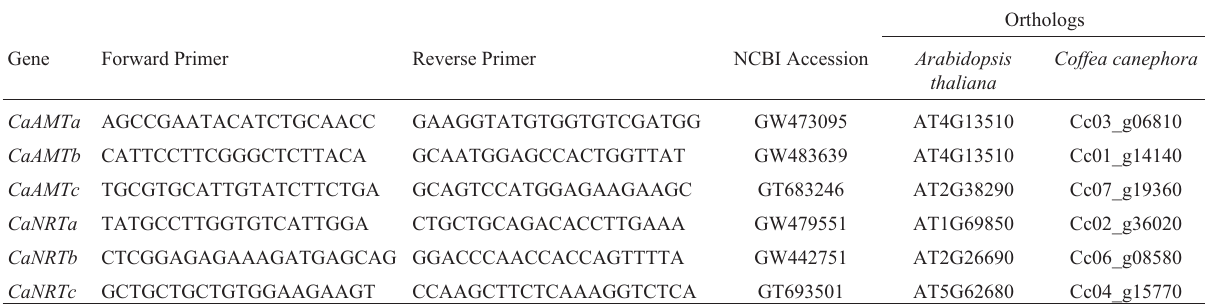
Table 1 - Coffea arabica transcriptional analysis: RT-PCR primers and orthologs in Arabidopsis and C. canephora